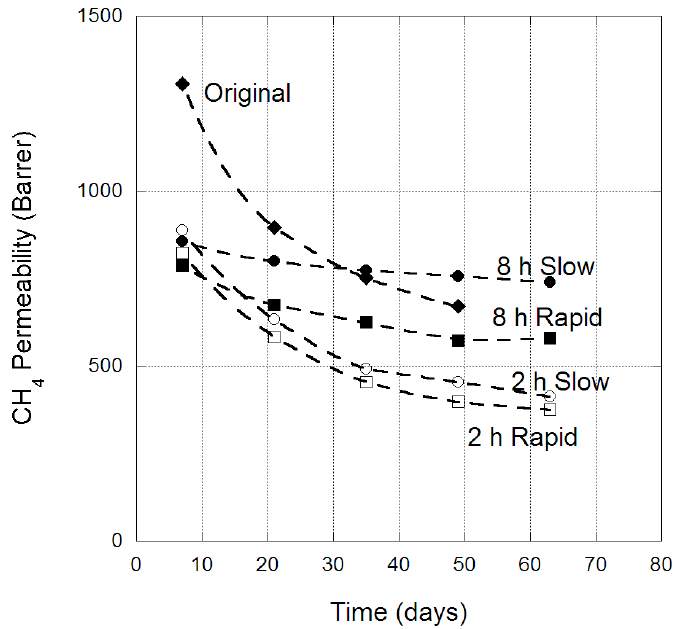
Figure 5. CH 4 permeability (barrer) in PIM-1 membrane over time, for the original and scCO 2 -treated states, at 35 °C.